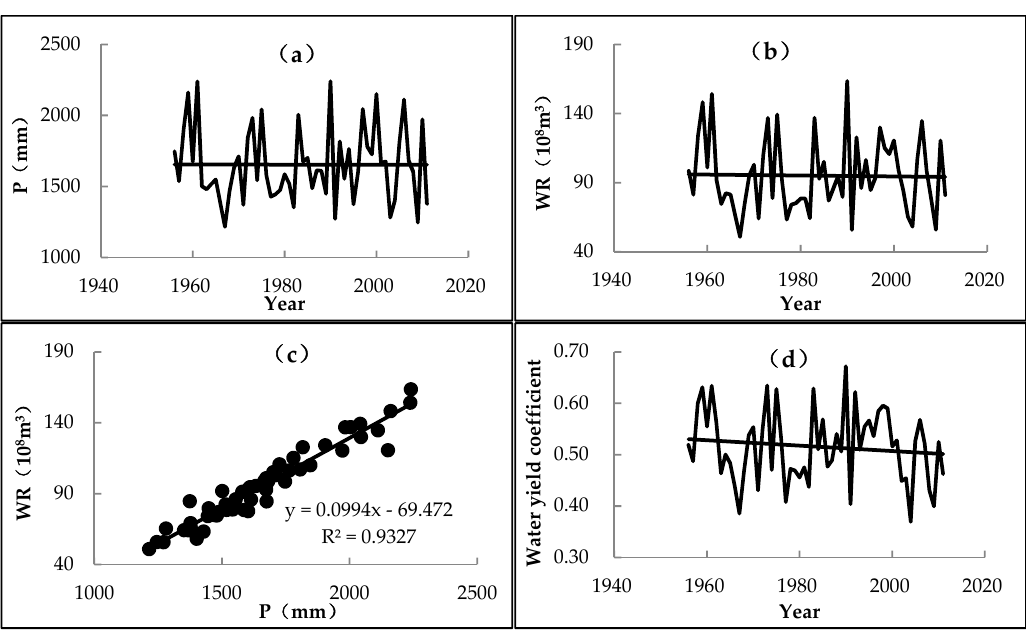
Figure 2. Annual precipitation, water resources potential, their relationship and the water yield coefficient in Quanzhou (1956–2011).